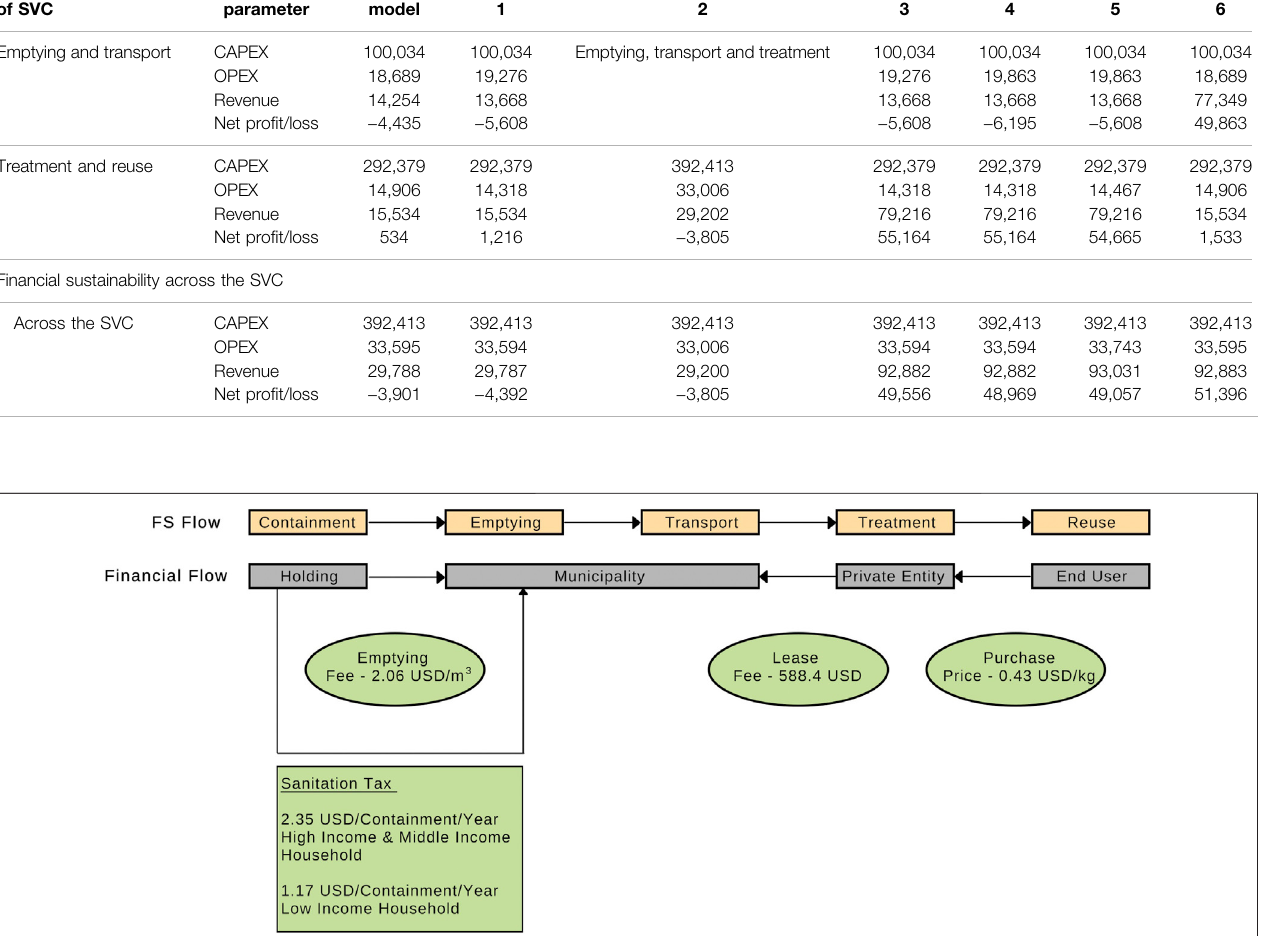
Frontiers in Environmental Science |